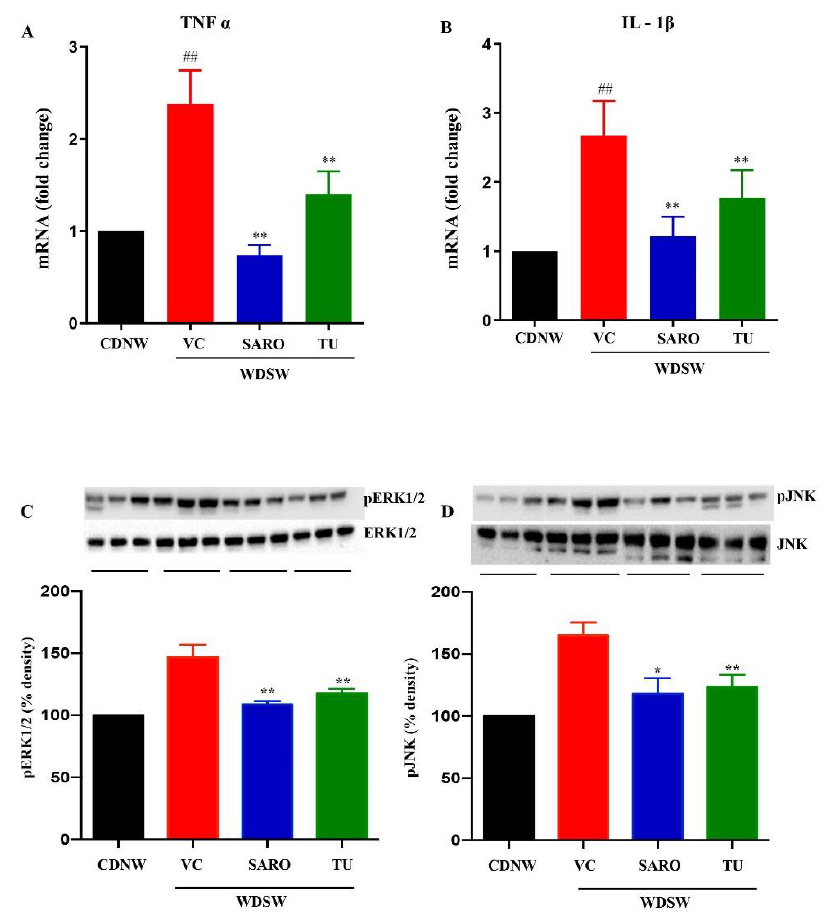
Figure 7. Tecomella undulata ( TU ) treatment ameliorated hepatic inflammation in NASH mice. The relative expression of hepatic mRNA levels of TNF α ( A ), and IL-1 β ( B ) were determined using qRT- PCR. The experiments were carried out in triplicate and β -actin was used as an endogenous control for normalizing the mRNA levels. Whole cell lysates were prepared from liver tissue of CDNW and WDSW treated with vehicle control (VC), saroglitazar (SARO) or Tecomella undulata (TU) for 12 weeks. Immunoblot analyses were performed for p-Erk1/2 and Erk1/2 ( C ), and p-JNK and JNK ( D ). Bar graphs show the densitometric values calculated after normalization to total Erk1/2 or total JNK. Data are expressed as the mean with SEM. ## p < 0.001 compared to CDNW; ** p < 0.001, * p < 0.05 compared to WDSW, vehicle control. TNF α , tumor necrosis factor α ; IL-1 β , interleukin- 1 β ; p-Erk1/2, phospho-extracellular signal-regulated protein kinase; p-JNK, phosphor- c-Jun N-terminal kinase. Taken together, our results showed that Tecomella undulata could alleviate western diet sugar water-induced ER stress and oxidative stress, improve liver injury and antioxidant status, and thereby reduce inflammation (Figure